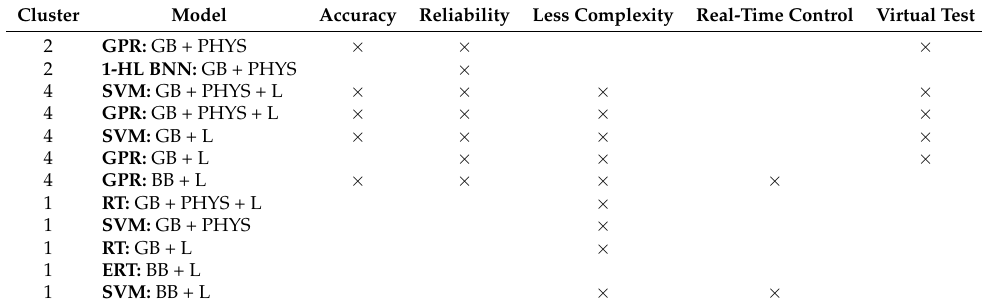
Figure 11. Second filter clustering of Models using K-means algorithm: 28 models divided to 5 clusters where three clusters including 12 models have been chosen as final selection. ( a ) R 2 test , ( b ) RMSE test [ mg/m 3 ] , ( c ) Table 5. Selected models based on K-means